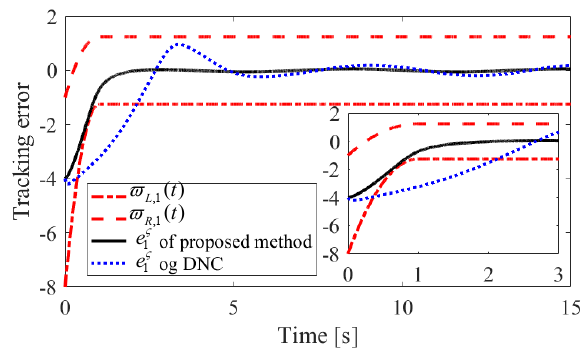
Figure 9. Convergence performance of e ς